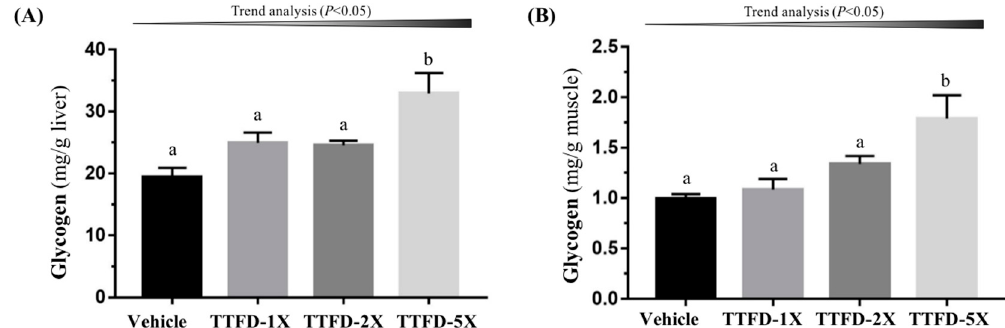
Figure 7. Effect of 4-week TTFD supplementation on hepatic ( A ) and muscle ( B ) glycogen levels. Data are mean ± SEM for n = 10 mice per group. Bars with different letters (a, b) are significantly different at P < 0.05.